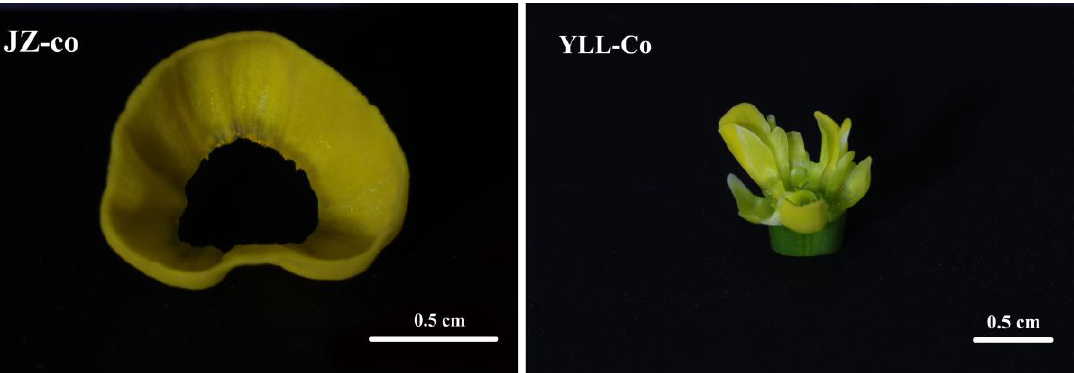
Figure 10. Anatomical morphologies of the corona of JZ and YLL at the full-bloom stage. JZ-co—JZ corona; YLL-Co—YLL